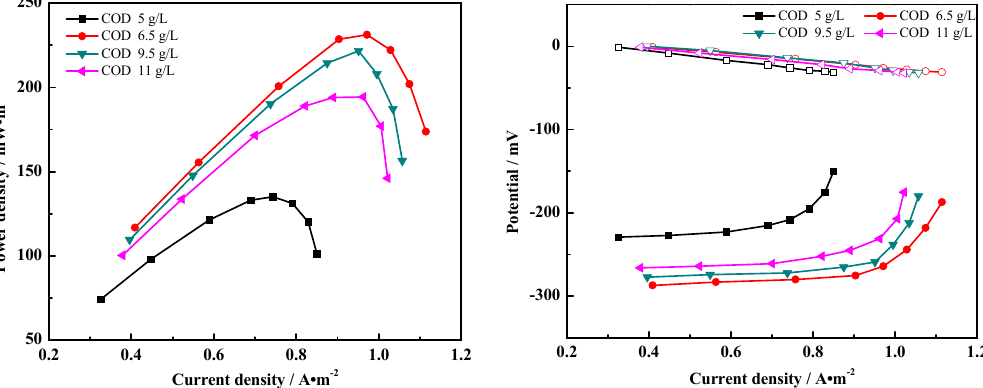
Figure 3. Power density curve ( Left ) and polarization curve (( Right ): close circuit symbol, cathode potential; open circuit symbol, anode potential) under different COD concentrations.